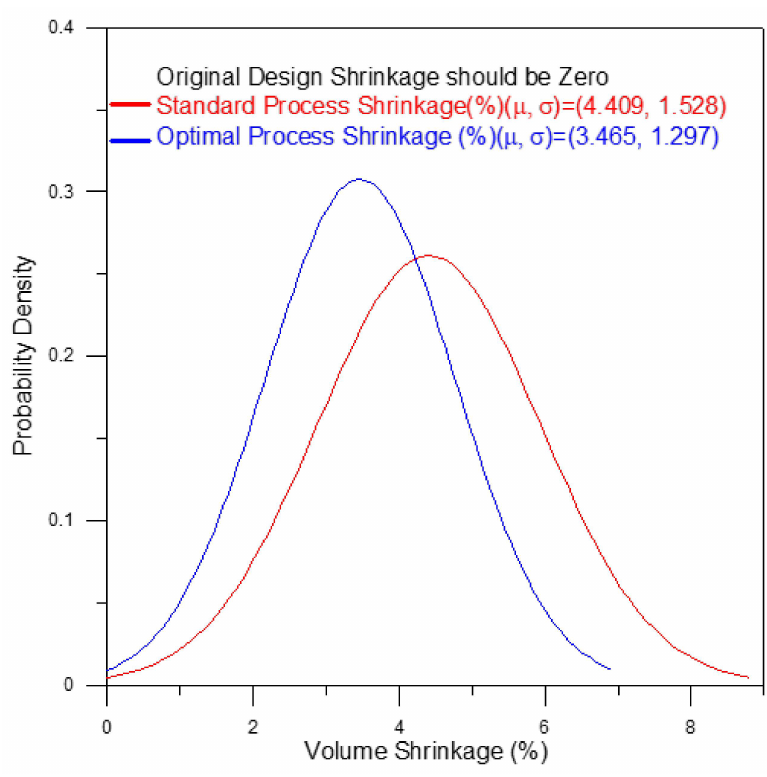
Figure 13. Shrinkage improvement of optimal process compared to standard